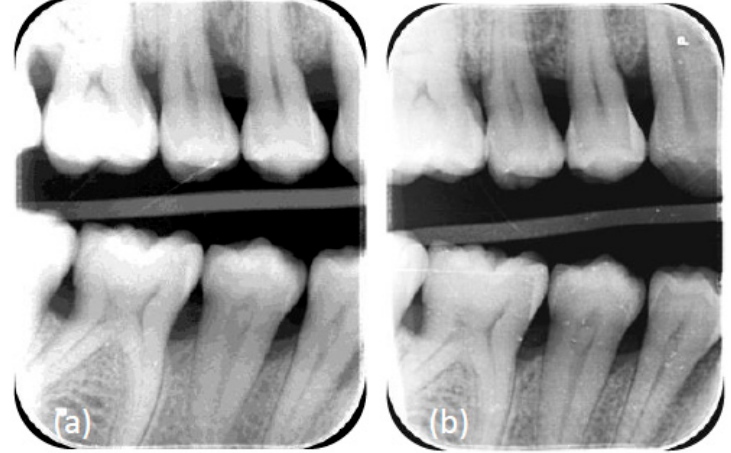
Figure 4. ( a ) Radiographic view of the angular defect 15 M before regenerative intervention. ( b ) Radiographic view of the angular defect mesial to 15 6 months after the intervention, attesting to a good healing capacity after periodontal surgery.